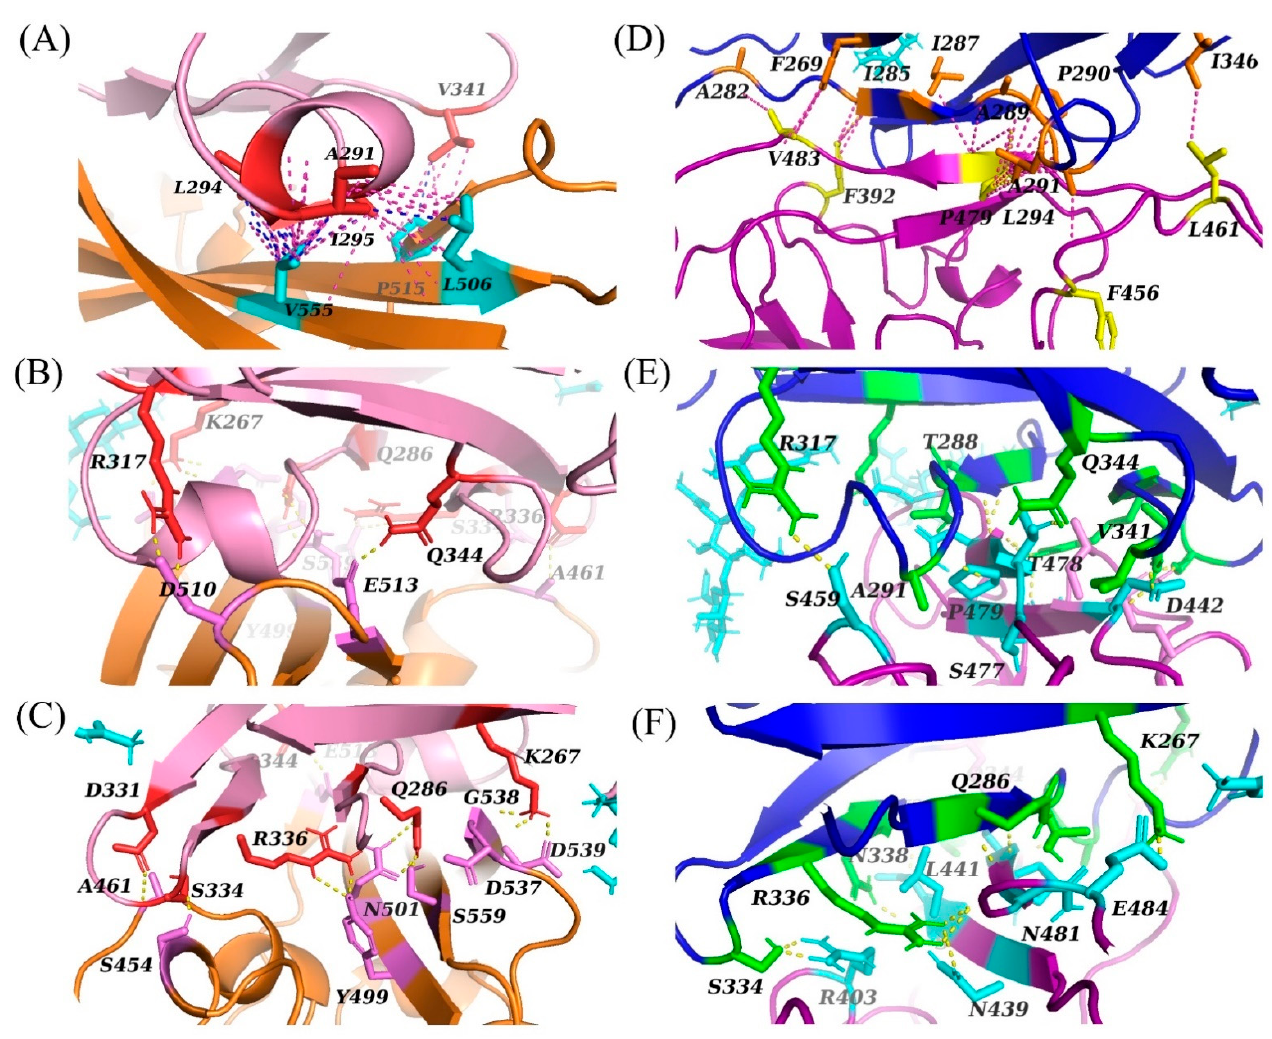
Figure 6. Predicted interactions between the RBD of MERS-CoV and remodelled SARS-CoV-2 with DPP4 obtained using flexible molecular docking with HADDOCK. ( A – C ) Binding interactions between MERS-CoV (orange) and DPP4 (pink). ( D – F ) Binding interactions between the remodelled structure of SARS-CoV-2 (purple) and DPP4 (blue). Hydrophobic interactions (magenta and blue) in both complexes are shown in panels ( A , D ). Polar interactions (yellow) to the right of the hydrophobic α -helix are described in panels ( B , E ), and to the left of the hydrophobic α -helix are described in panels ( C , F